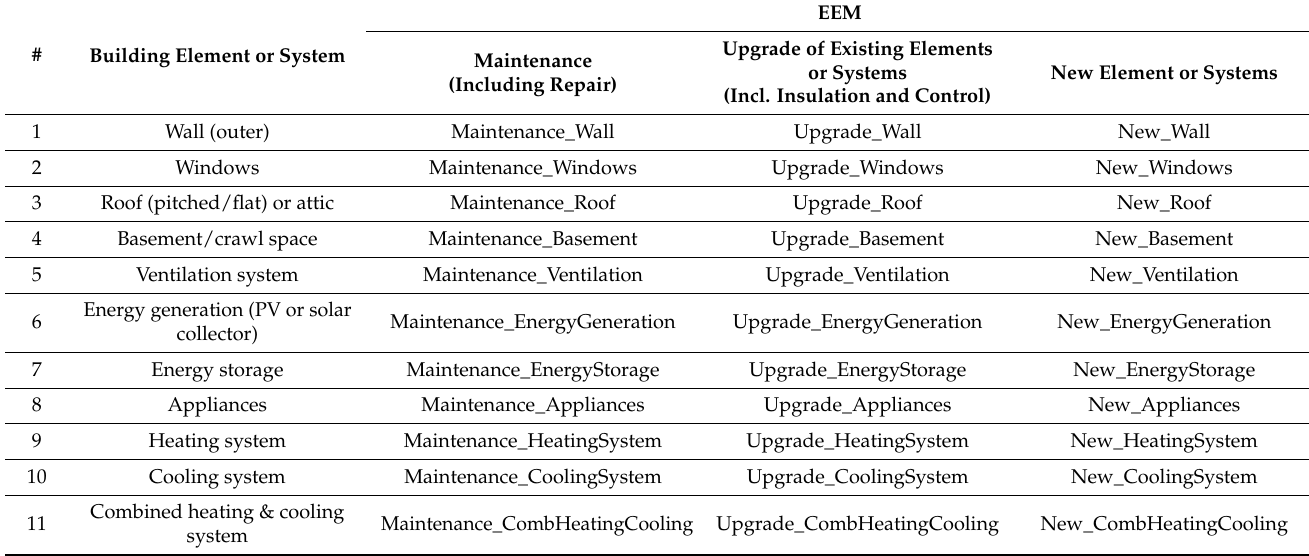
Table 3. EERMs and respective variable name in the model.